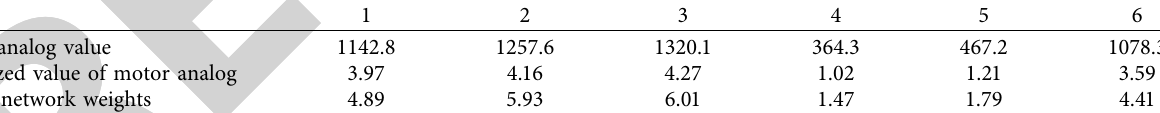
Figure 3: Structure of the biped robot. Table 4: Network weight sample data table.